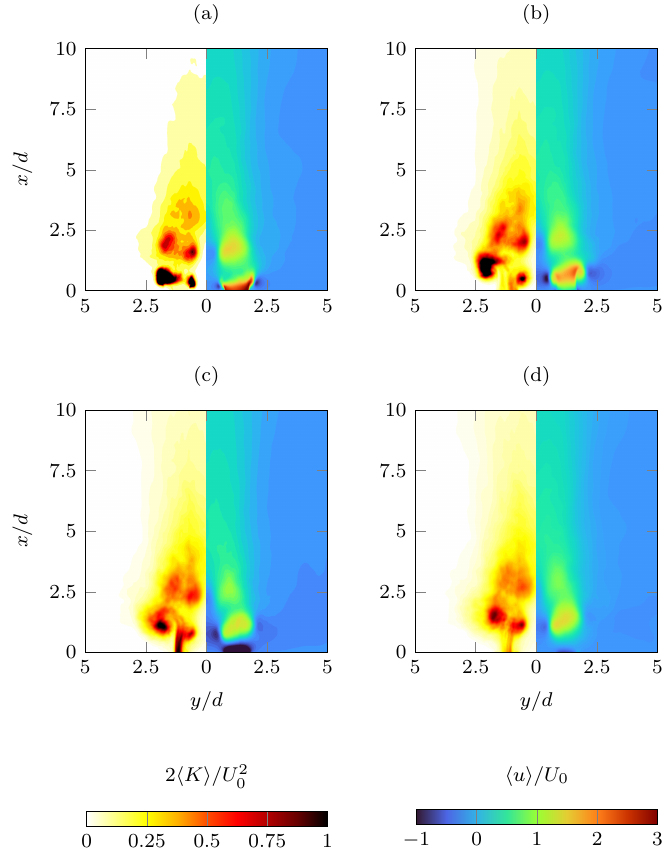
= 0.05, t / T = 0.375, s o / d = 2.5 ( left ), s o / d = 5 ( right ). u Q / U 0 : (cid:104) (cid:105) (cid:104) (cid:105)